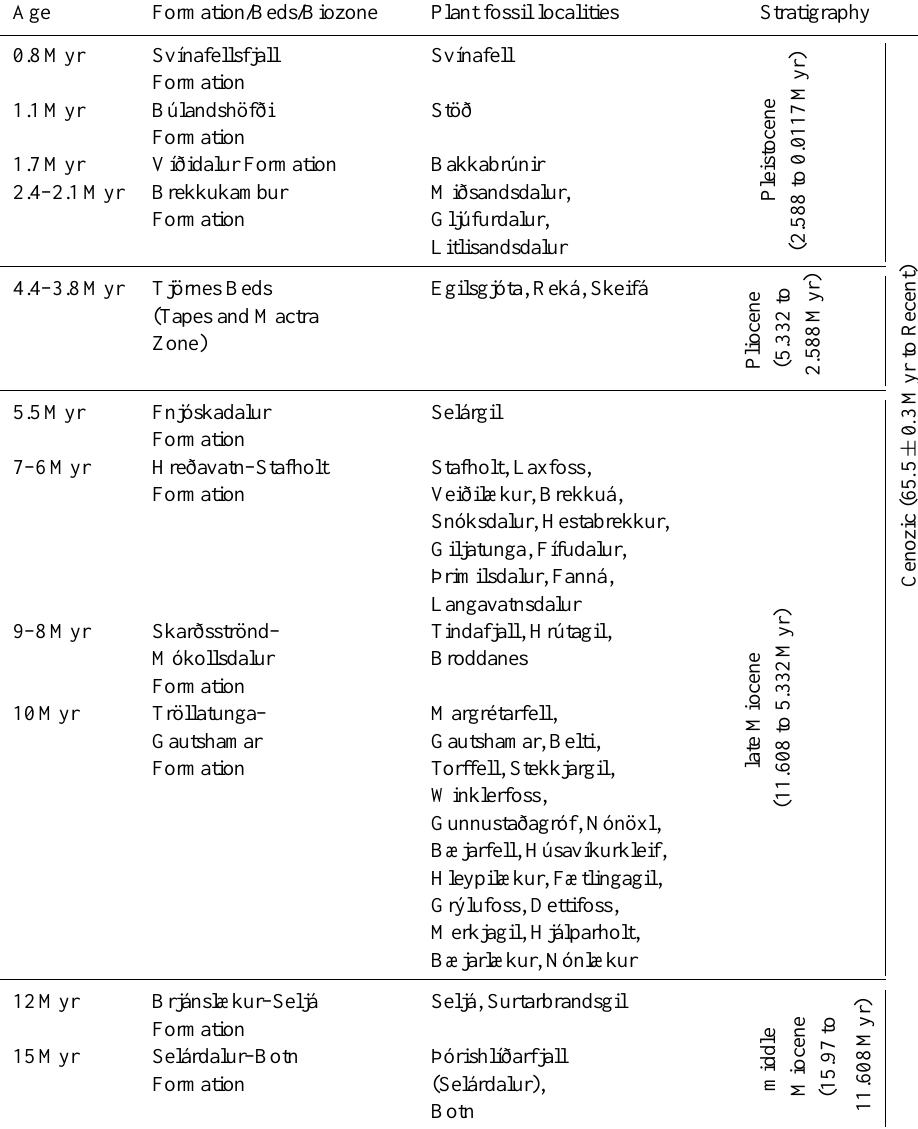
Table 1. Age and stratigraphy of plant-bearing sedimentary rock formations from Iceland (after Denk et al., 2011). Age Formation/Beds/Biozone Plant fossil localities